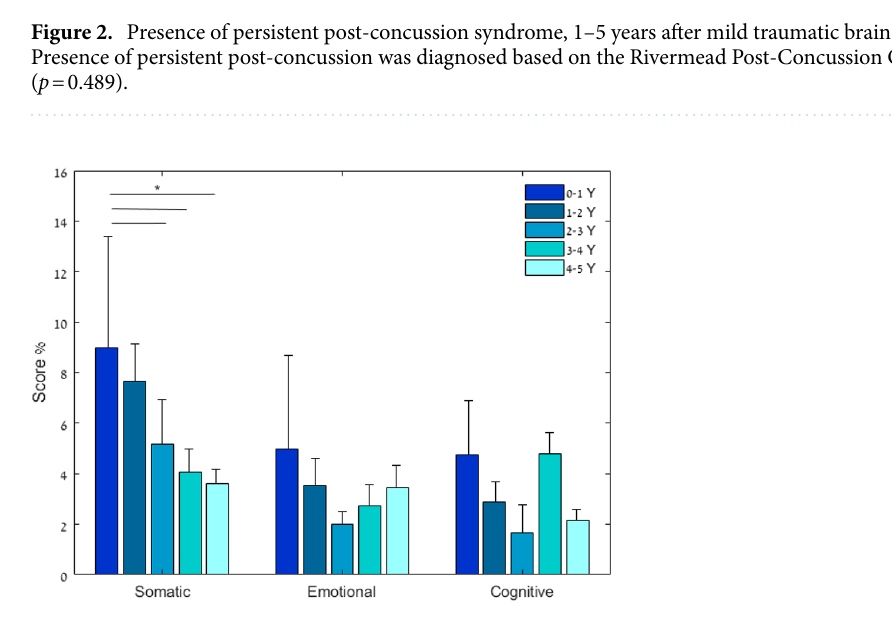
Figure 3. Rivermead Post-Concussion Questionnaire symptom severity scores presented as a three-model symptom factors (somatic, emotional, cognitive) in symptomatic post-mild traumatic brain injury children (N = 52). Rivermead Post-Concussion Questionnaire (RPQ). Values are presented as percentage of severity level: Somatic [0–36], emotional [0–16], cognitive [0–12] 21 . The somatic symptoms score severity was significantly lower 24 months after injury ( p =